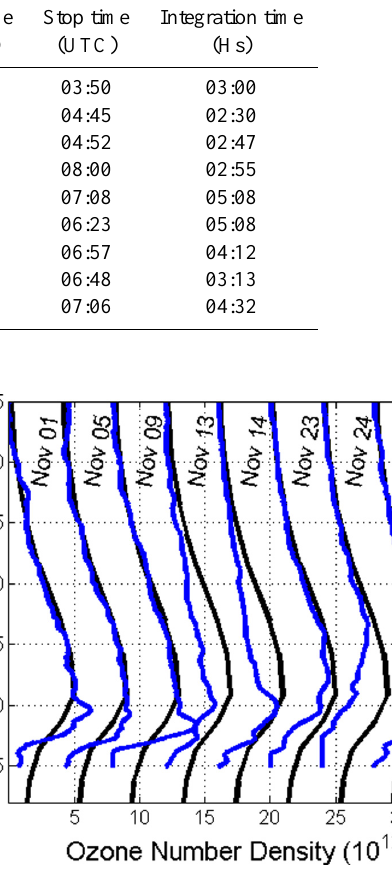
Fig. 3. Lidar ozone profiles measured in R´ıo Gallegos sites (blue lines) from 1 November to 13 December 2009. The details of li- dar experiments are listed in Table 2. For comparison of vertical ozone profile shape change, the November climatological Fortuin and Kelder ozone profile is included (black lines). The profiles have been offset successively by 4 × 10 12 cm − 3